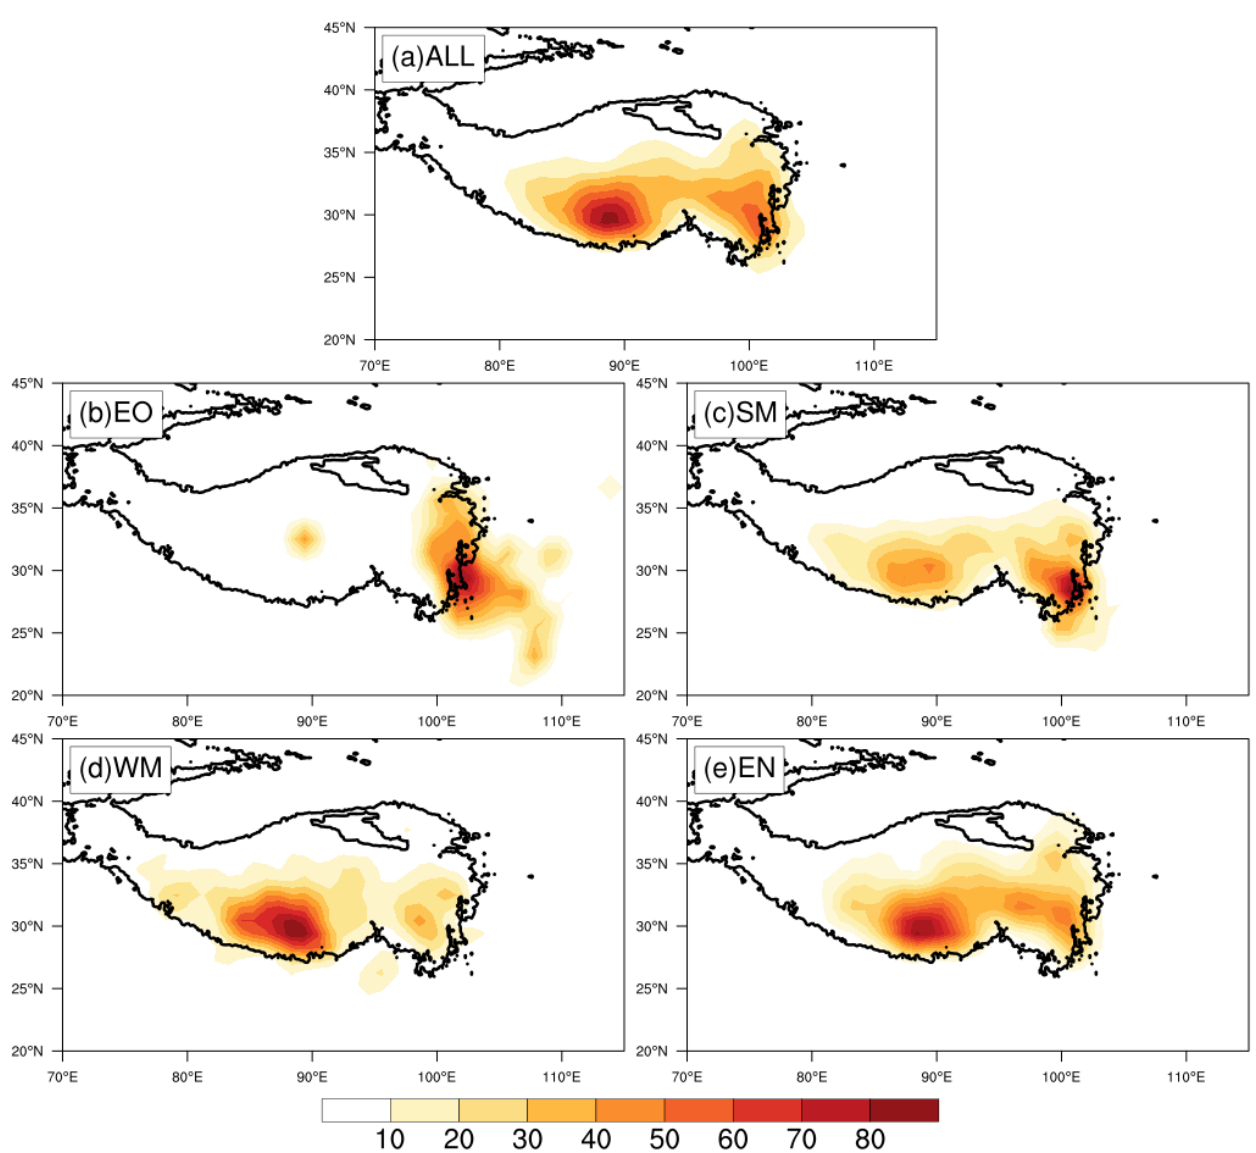
Figure 14. Spatial distribution of P max over the TP on 1° × 1° grids. ( a ) All MCSs; ( b ) EOs; ( c ) SMs; ( d ) WMs; ( e ) ENs. The differences in occurrence time ( Δ t) between BT min and P max are shown in Figure 15. SMs, WMs and ENs showed similar features in each month. Among most events, the ∆ t values ranged between –12 and 6 h, and BT min occurred earlier than P max for more than 80% of MCSs. A ∆ t of between − 6 and 3 h was observed for 90% of non-EOs but only 80% of EOs. The proportion of EOs with positive ∆ t is obviously larger than that of non-EOs. Results indicate that the peak in precipitation was usually followed by a minimum in brightness temperature over the TP. The occurrence of BT min ahead of P max is in agreement with what was obtained from a single cell [49], which can be explained by intense precipitation usually resulting from a rapid vertical updraft. The remaining MCSs for which BT min was followed by P max may be multi-cell convective systems. When reaches its maximum [44]. This may be a possible explanation for long-lasting EOs.